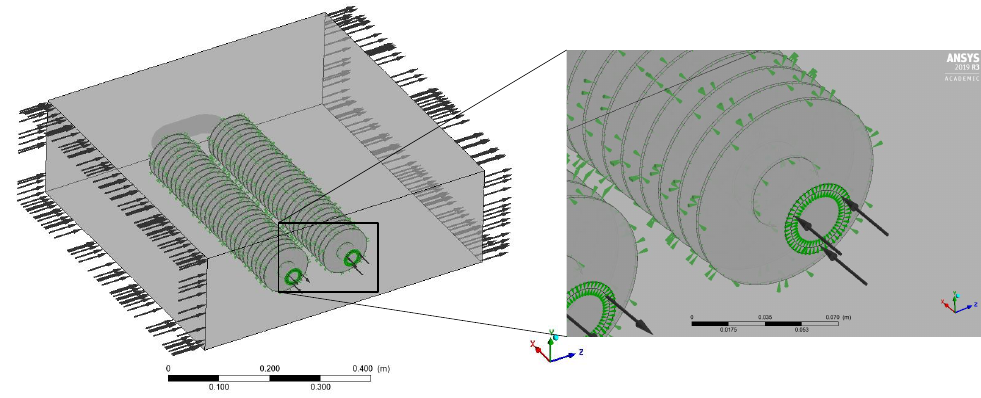
Figure 6. The investigated